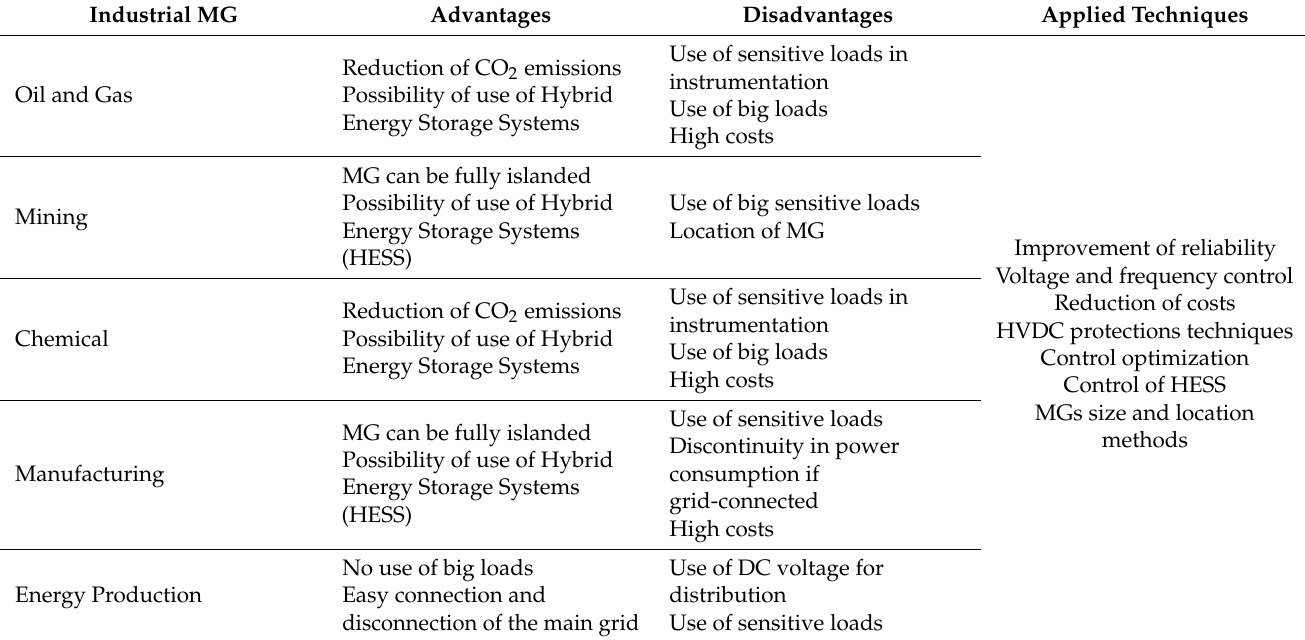
Table 2. Industrial microgrids types, advantages, disadvantages, and applied techniques (source: own